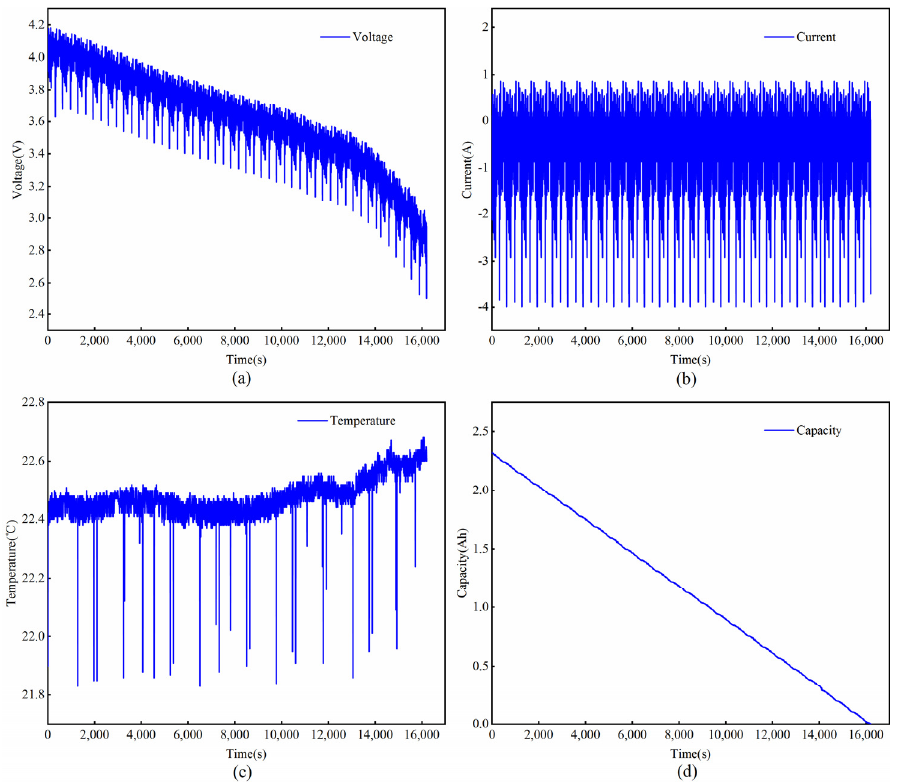
Figure 5. Measured battery data in the US06 driving condition at 20 °C. ( a ) Battery voltage data. ( b ) Battery current data. ( c ) Battery temperature data. ( d ) Battery capacity data.